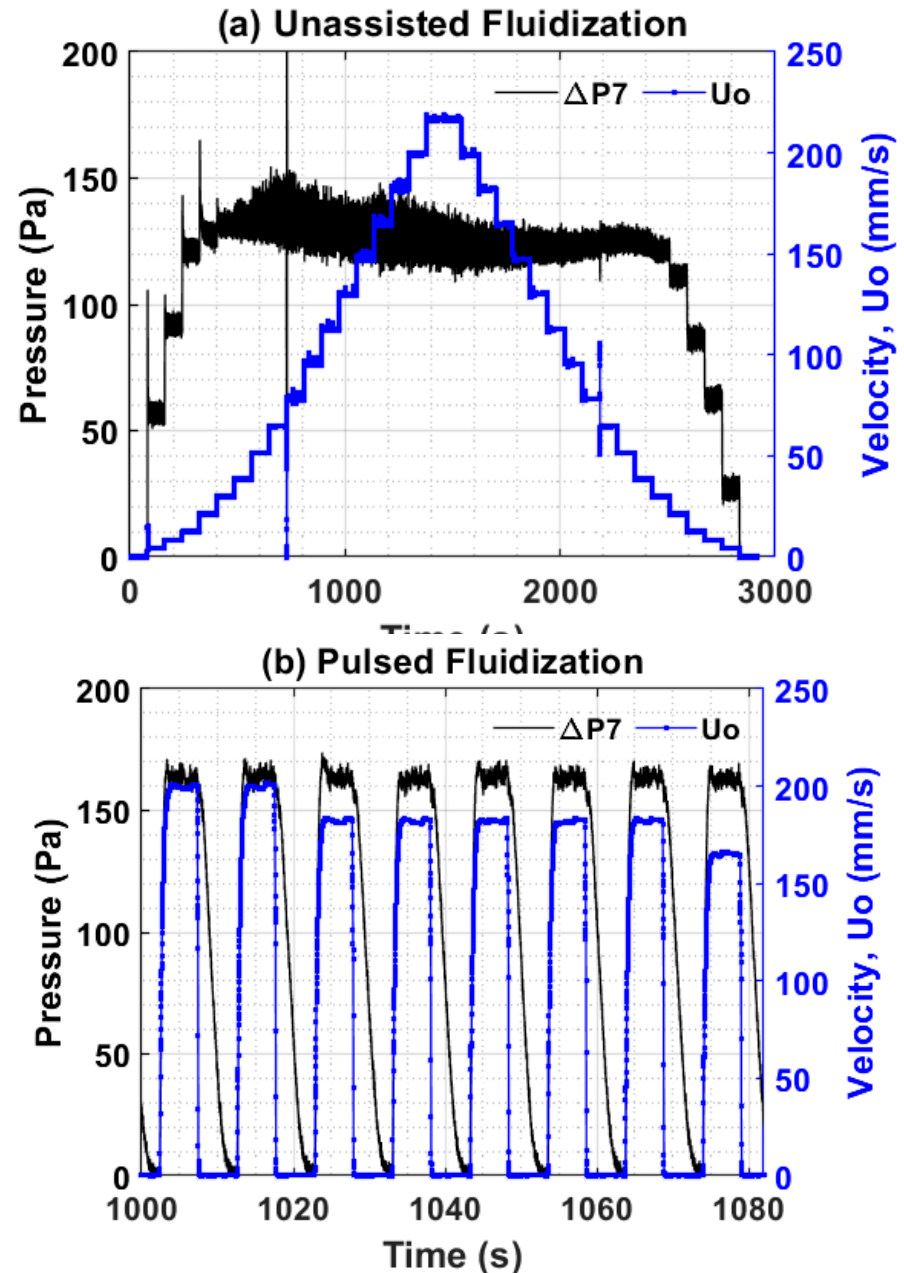
Figure 5. Velocity (U o ) and overall pressure drop transients ( ∆ P 7 ) for ( a ) unassisted fluidization and ( b ) pulsed fluidization.